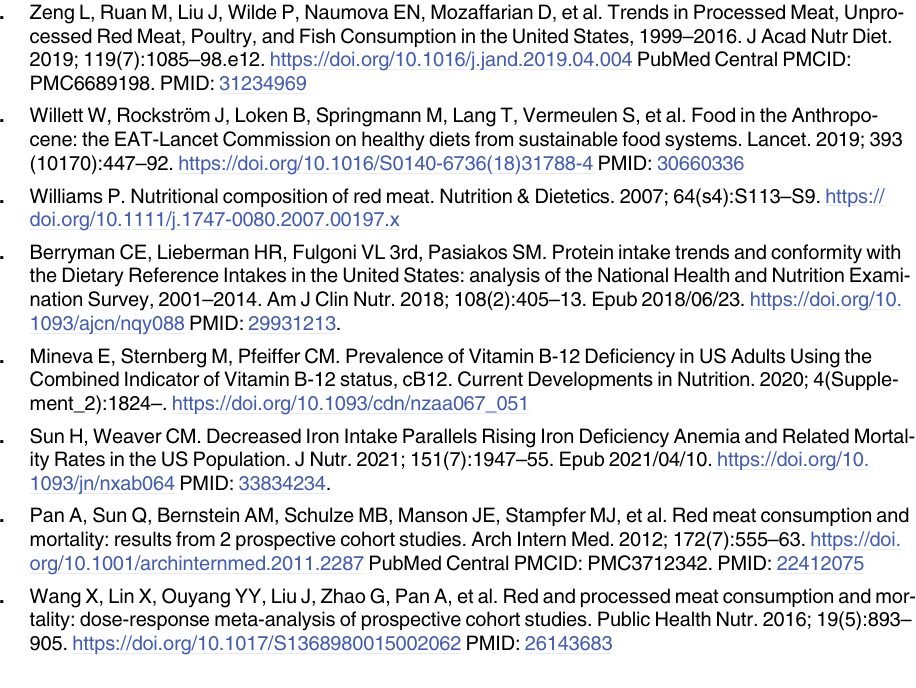
S1 Table. Adjusted perceived message effectiveness (PME) � and intention to reduce meat consumption in the next seven days � between Health and Environmental Messages. � Five- point Likert scale ranging from 1 “Not at all” to 5 “A great deal” †Results from linear regres- sion, adjusting for meat consumption as compared to a year ago. S2 Table. P-Values from Z-Tests comparing messages selected as most discouraging by